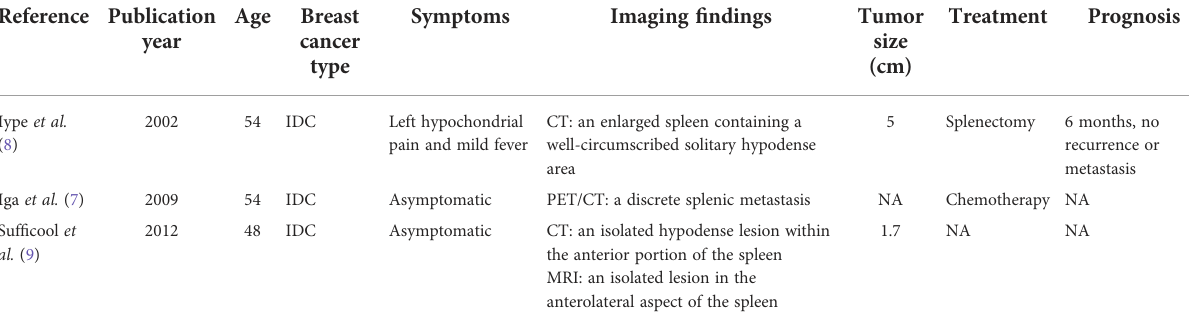
TABLE 1 Cases published in the literature of solitary splenic metastasis from breast cancer.